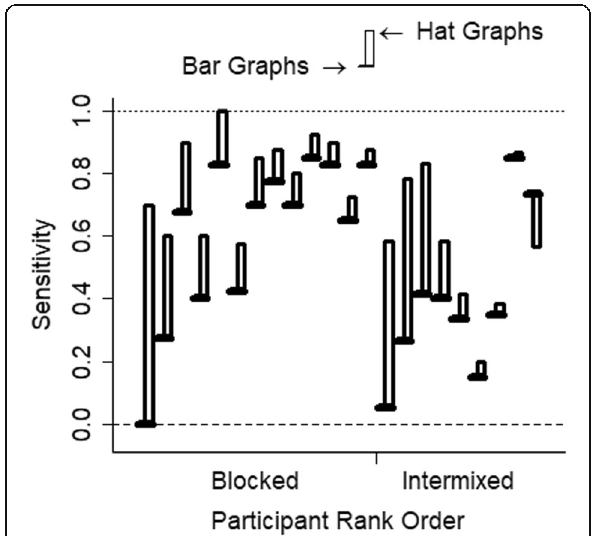
Fig. 13 Sensitivity is plotted for each participant for each graph type. The brim of the hat corresponds to sensitivity with the bar graphs, and the crown corresponds to sensitivity with the hat graphs. Sensitivity was measured as the slope in linear regressions, and higher values correspond to better sensitivity. A slope of 1 corresponds to perfect sensitivity whereas a slope of 0 indicates no sensitivity. The brims correspond to the bar graph condition whereas the crowns correspond to the hat graph condition. Participants are grouped by design (blocked versus intermixed) then ranked with respect to how much more sensitive they were with the hat graphs compared with the bar